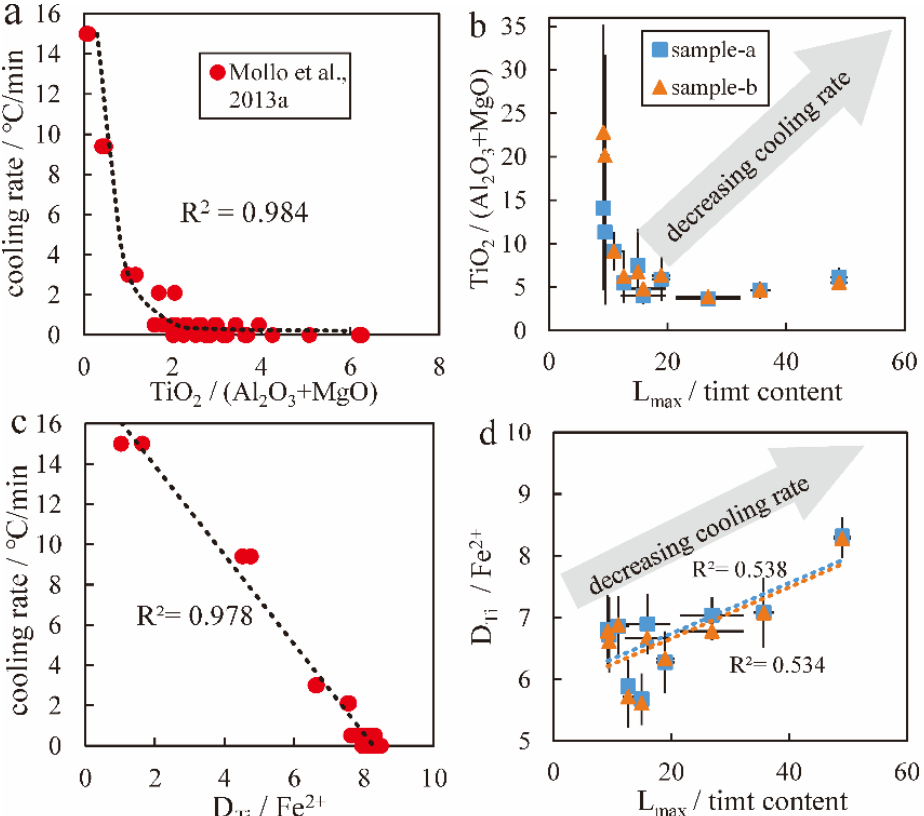
Figure 13. Relationship between the ( a ): cooling rate and TiO 2 /(Al 2 O 3 + MgO) in titanomagnetite; ( b ): Lmax/timt content and TiO 2 /(Al 2 O 3 + MgO) in titanomagnetite; ( c ): cooling rate and DTi/Fe 2+ ; ( d ): Lmax/timt content and DTi/ Fe 2+ . Two independent tests were conducted to obtain two sets of data (15 particles for each test), marked as ‘sample-a’ and ‘sample-b’, respectively. The error bar is the standard deviation of fifteen electron probe data points for each sample. TiO 2 , Al 2 O 3 and MgO are wt%, and timt Fe 2+ is